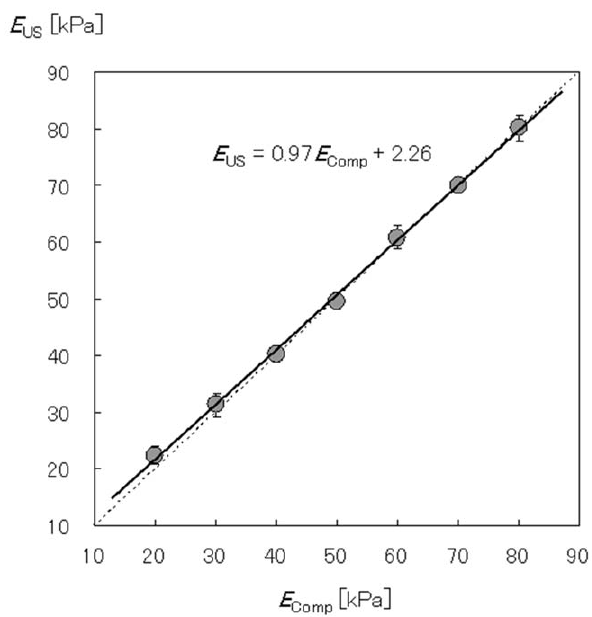
Figure 4. The Young’s modulus of the medial gastrocnemius muscle (MG). The Young’s modulus of MG was measured at 20 u dorsiflexion, anatomical position, and 30 u plantar flexion. The anatom- ical position of the ankle is considered as 0 u (i.e., 90 u between the tibia and the sole). Dorsiflexion is considered negative while plantar flexion is considered positive. Young’s modulus significantly decreased with plantar flexion (* P , 0.05).